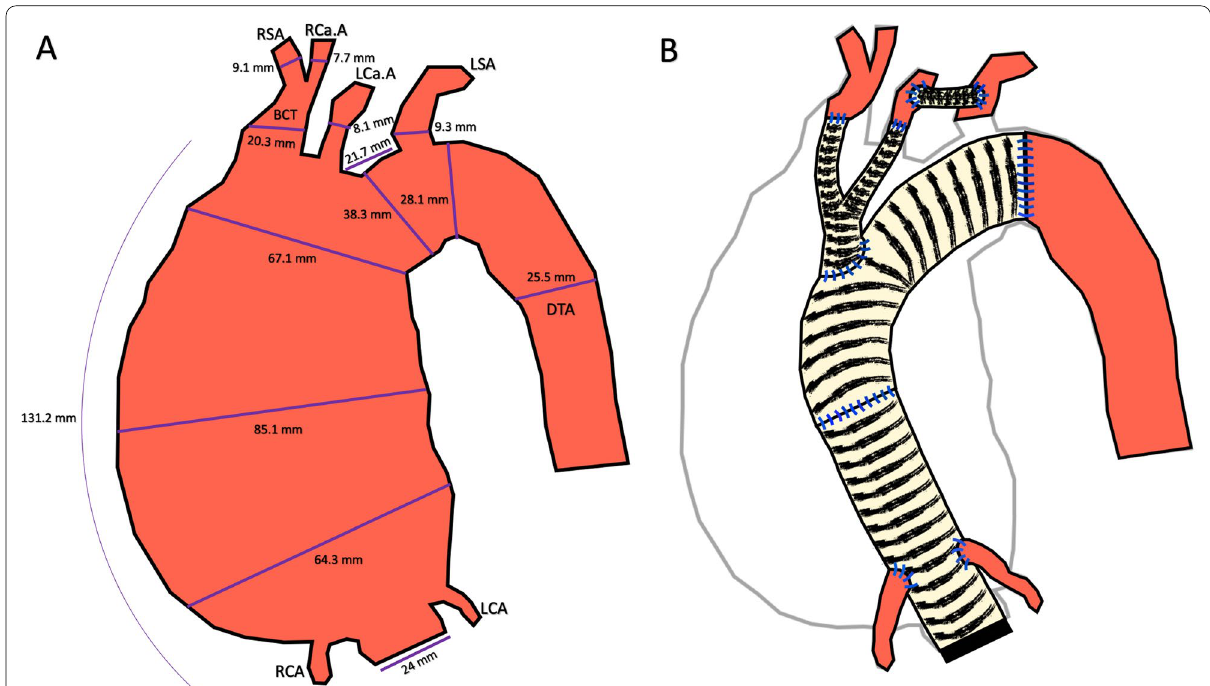
Fig. 2 A Preoperative diagrammatic view: measurements of the ATAA and supra‑aortic vessels. B Postoperative diagrammatic view: Bentall Surgery Total Aortic Arch Replacement with Supra‑Aortic Vessel Debranching. RCA Right Coronary Artery, LCA Left Coronary Artery, BCT + Brachiocephalic‑Trunk, RSA Right Subclavian Artery, LSA Left Subclavian Artery, RCa.A Right Carotid Artery, LCa.A Left Carotid Artery, DTA Descending Thoracic Aorta